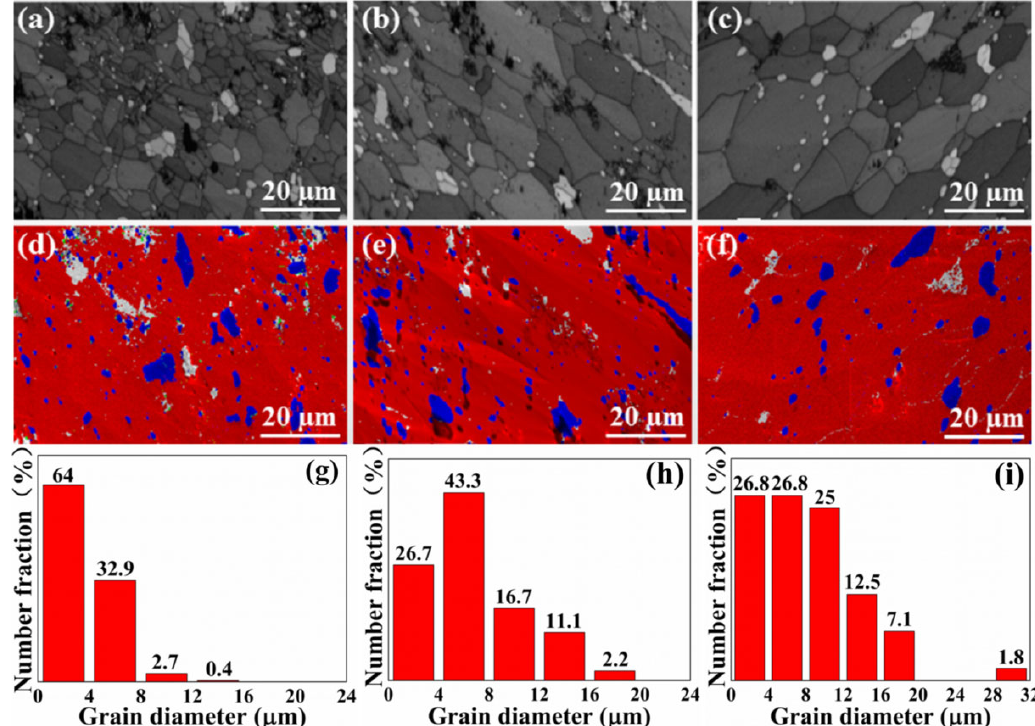
Fig. 3 Microstructures of samples fabricated at various temperatures observed by EBSD. Micrograph in band contrast: (a) 1300, (b) 1400, (c) 1500 ℃ ; phase distribution: (d) 1300, (e) 1400, (f) 1500 ℃ (Y 3 Si 2 C 2 in red and Y 2 O 3 in blue); grain size distribution: (g) 1300, (h) 1400, (i) 1500 ℃ .